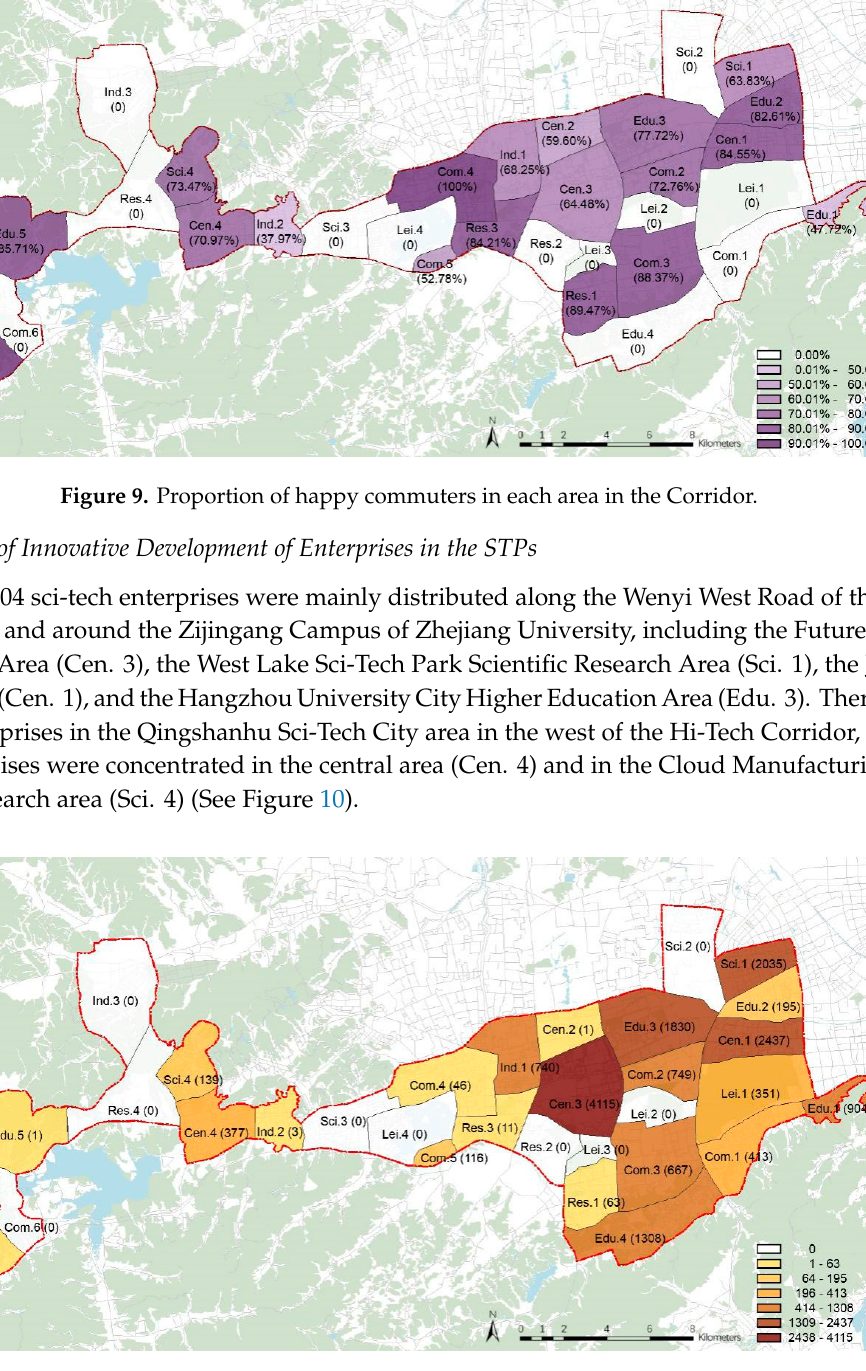
Figure 8. Average commuting distance of each area in the Corridor (units are in meters).